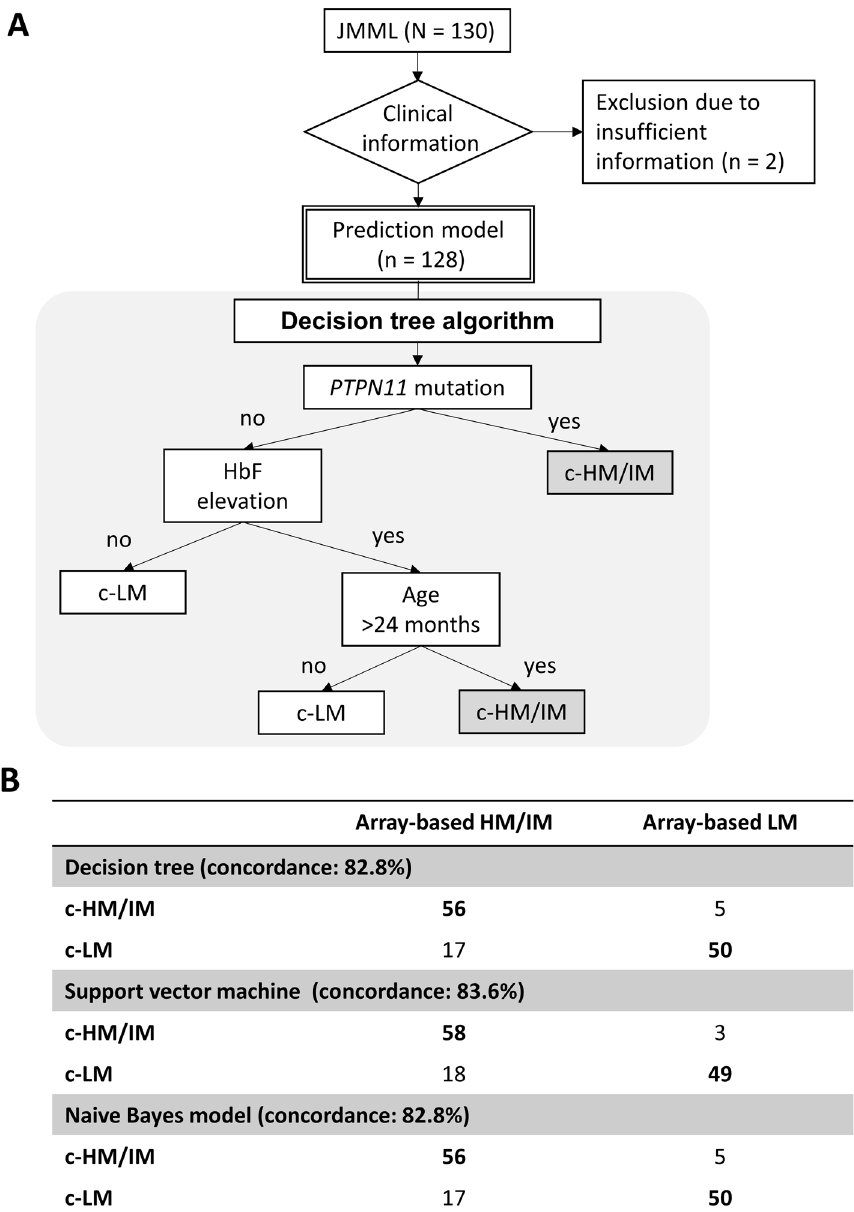
Figure 1. Clinical prediction model of dichotomized DNA methylation classification. ( A ) Flow diagram for DNA methylation profiles of patients used for the development of machine learning algorithms to predict DNA methylation classification. Patients from UCSF and the Japanese cohort who had methylation classification results were eligible for this analysis (N = 130). After excluding patients with incomplete clinical information (n = 2), 128 patients were included. Then, we implemented three machine learning algorithms. The figure shows a decision tree to classify into c-HM/IM and c-LM using widely available clinical information. ( B ) Three types of algorithms were implemented: decision tree, support vector machine, and naïve Bayes model. The concordance rates were 82.8%, 83.6%, and 82.8%, respectively. JMML juvenile myelomonocytic leukemia, c-HM/IM clinically predicted high/intermediate methylation, c-LM clinically predicted low methylation, HM high methylation, IM intermediate methylation, LM low